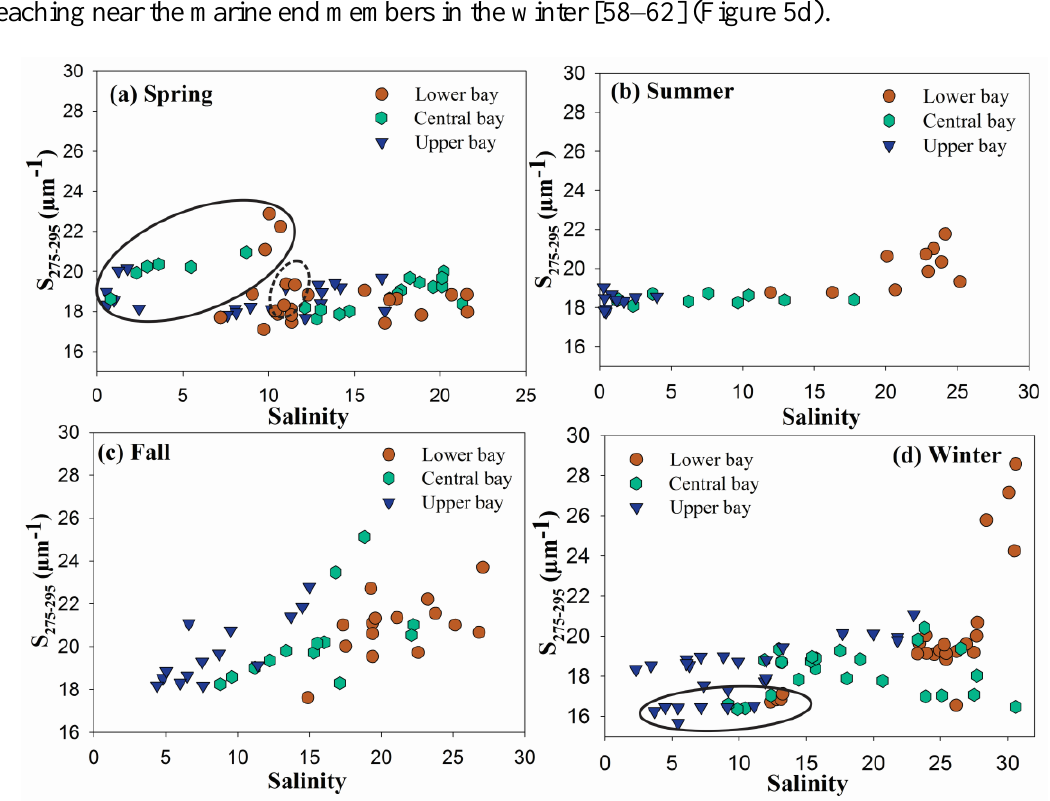
Figure 5. CDOM spectral slope vs. salinity relationship ( a ) spring, ( b ) summer, ( c ) fall, and ( d ) winter (the solid ellipse encloses similar measurements described in Figure